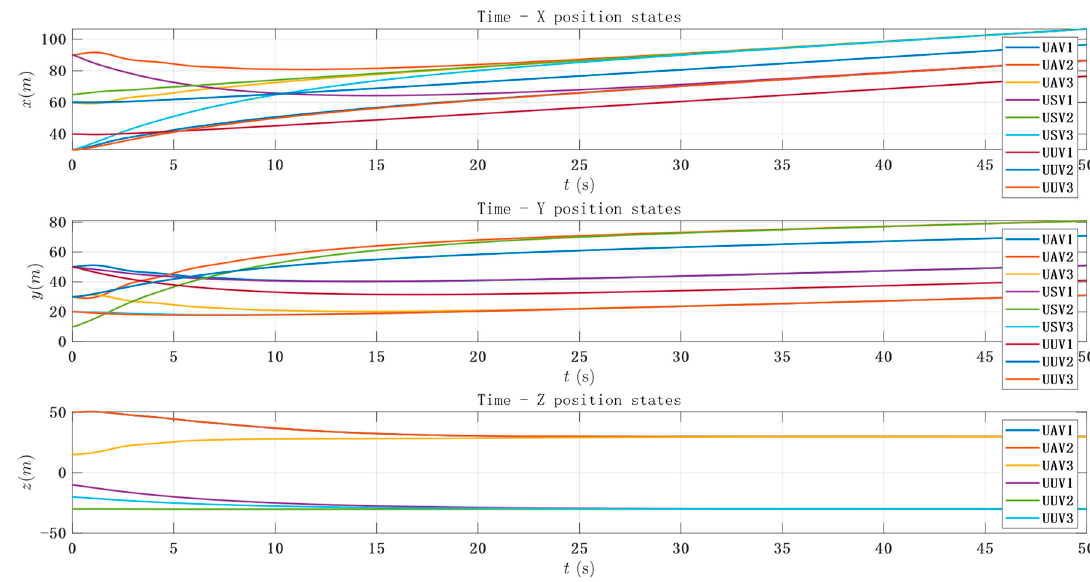
Figure 6. Formation state with dynamic formation control.